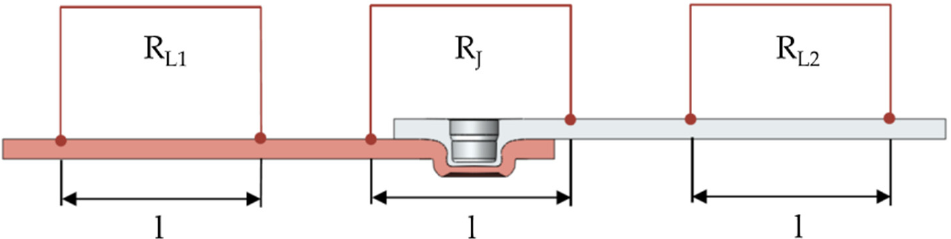
Figure 4. Representation of the tapping of the material resistances and the connection resistance on a clinch sample.